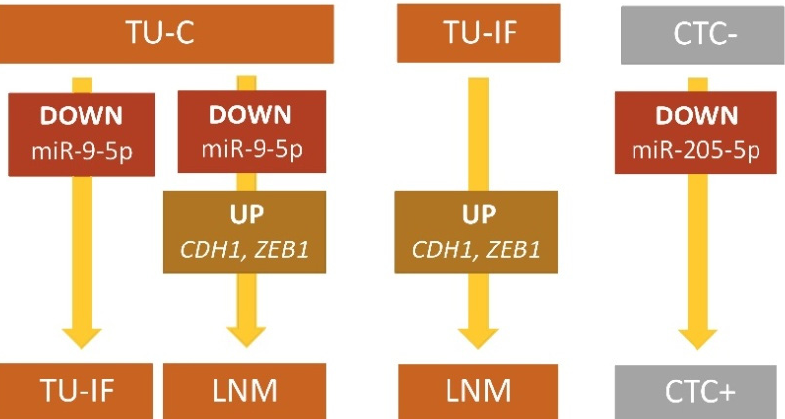
Figure 3. Expression of miRNAs, and CDH1 and EMT genes between different types of BC patients’ samples, namely in tumor centrum (TU-C), tumor invasive front (TU-IF) and lymph node metastasis (LNM), and in CD45-depleted blood (CD45-DB) fractions without and with identified epithelial and/or mesenchymal markers (CTC- and CTC+). expressions of miRNAs, and CDH1 and EMT genes, and between CDH1 and each of EMT genes (Table 2 and Table S1). Negative correlation was found between miR-221-3p and TWIST1 gene in TU-Cs (correlation coefficient (r), r = − 0.470, p = 0.015), and miR-9 and SNAI1 gene in LNMs (r = − 0.607, p = 0.013). In CD45-DB fractions the negative correlations were observed more frequently, in CTC- samples between miR-124-3p and TWIST1 (r = − 0.883, p = 0.020), and miR-221-3p and ZEB2 (r = − 0.543, p = 0.024). In CTC+ specimens, miR-9, miR-205-5p and miR-720 negatively correlated with both SNAI1 and ZEB1 (r ranged from − 0.853 to − 0.588 and p -value from 0.001 to 0.044), miR-221-3p with ZEB1 (r = − 0.610, p = 0.035) (Table 2). No negative correlations were detected between expressions of CDH1 and any of EMT genes in tumor, LNM and CTC samples (Table S1).